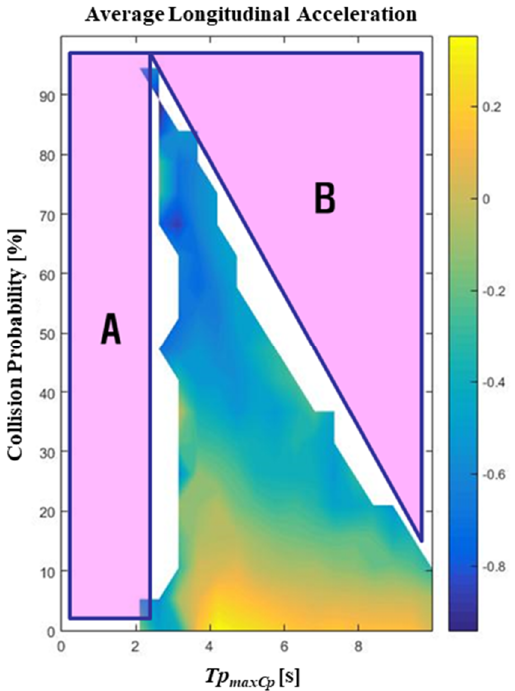
Figure 2. Human driver’s driving pattern with acceleration.